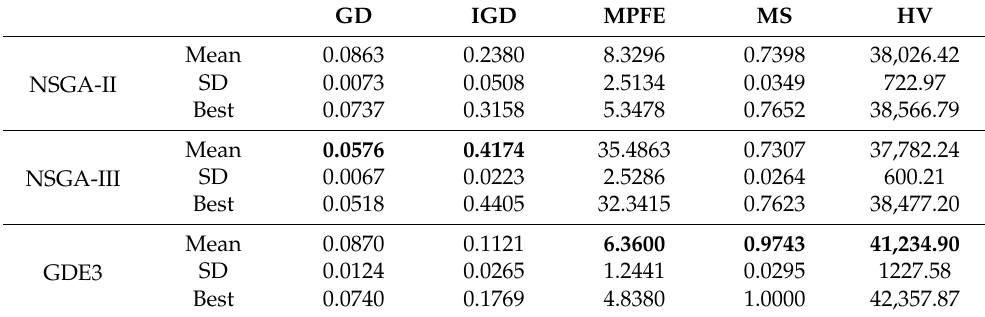
Table 4. Performance Metrics for NSGA-II, NSGA-III and GDE3 (Population = 50, Generations = 50). GD IGD MPFE MS HV